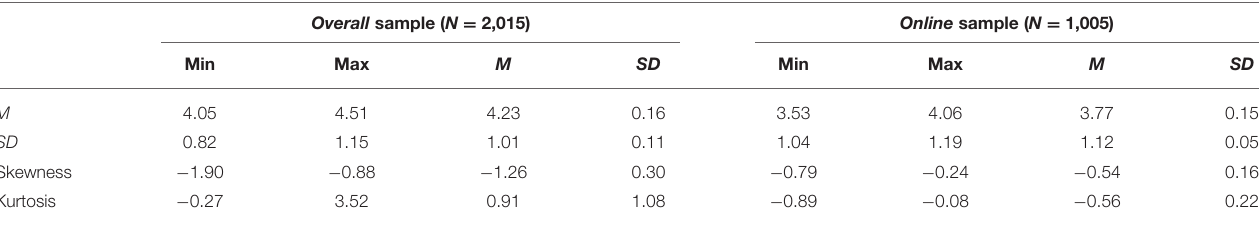
TABLE 1 | Summary descriptive Statistics of MGSES Items in overall and online